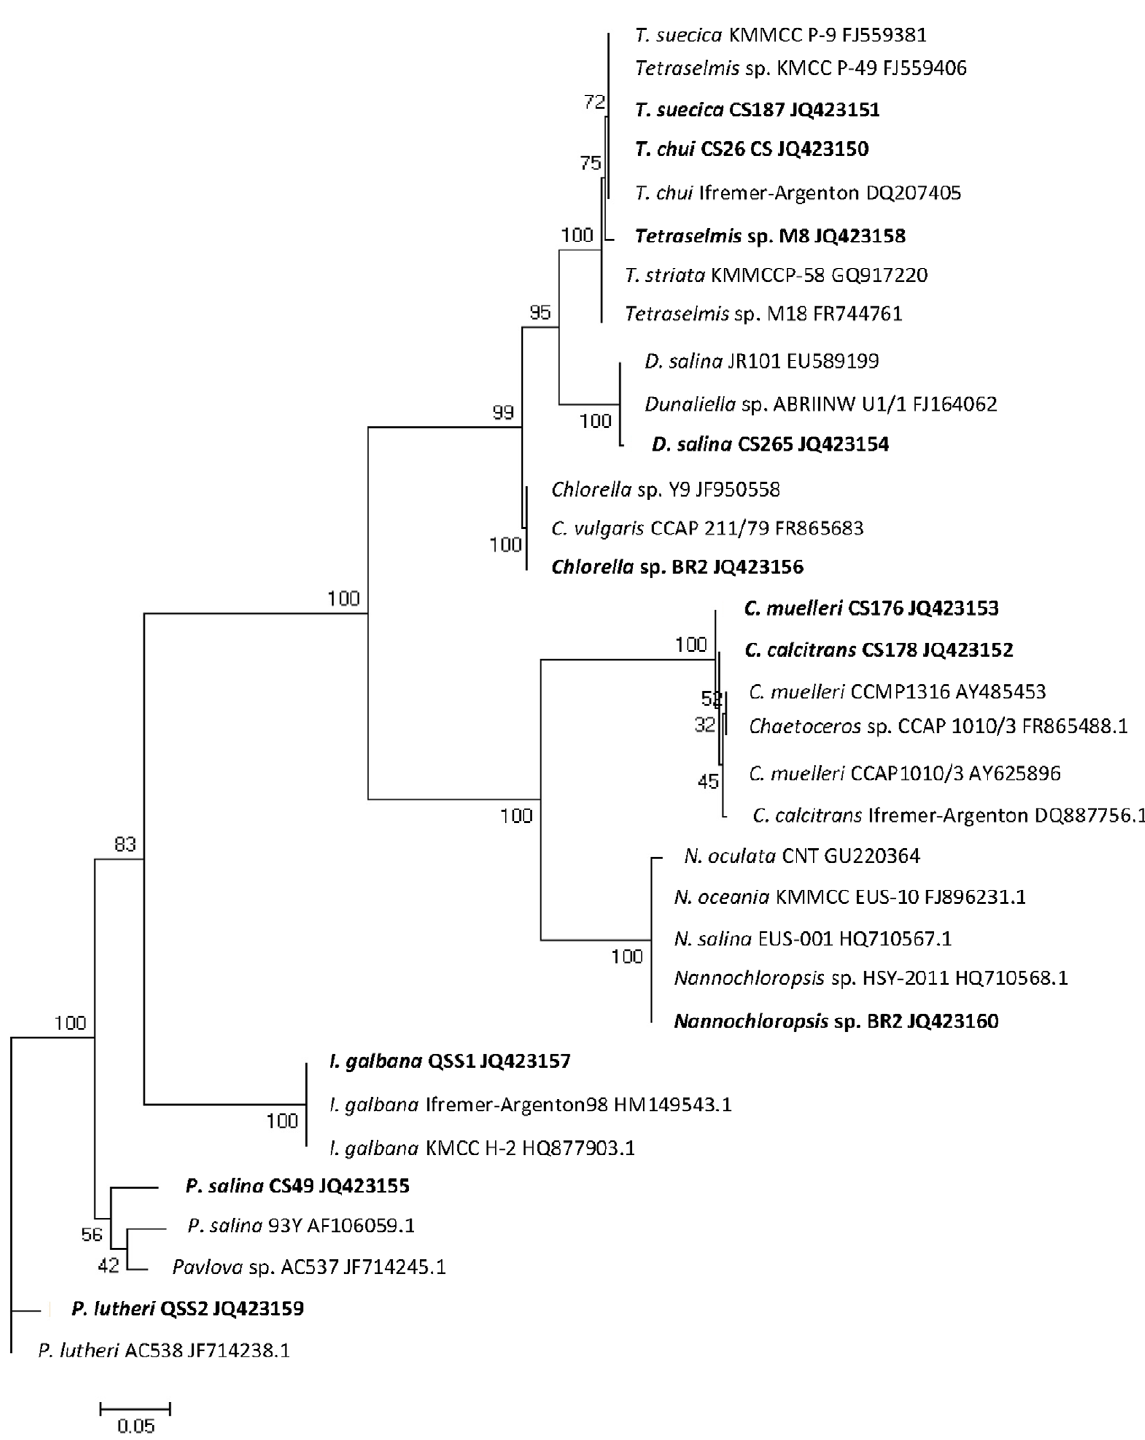
Figure 2. Maximum likelihood phylogenetic tree of 18S rRNA gene sequences from microalgae used in this study. Selected sequences from the NCBI database were also included (see Methods for selection criteria). Microalgae analyzed in this study are shown in bold. Numbers represent the results of 100 bootstrap replicates.